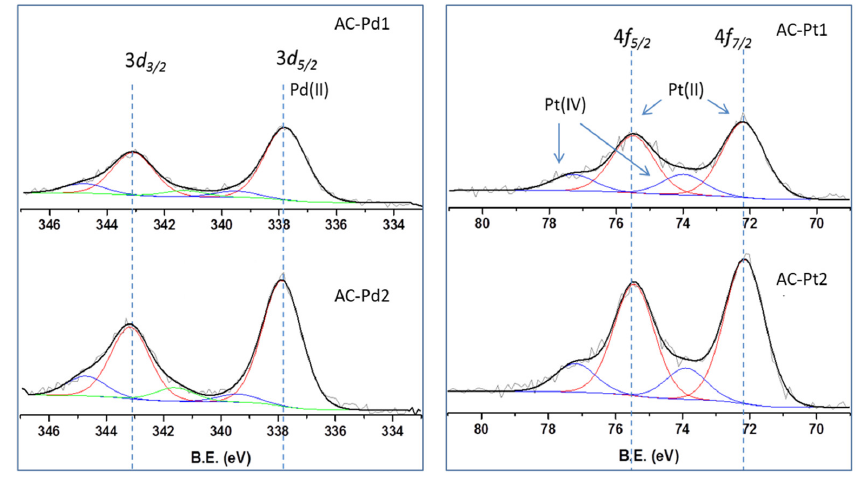
Figure 4. XPS profiles of the catalysts in the Pd 3d and Pt 4f regions.